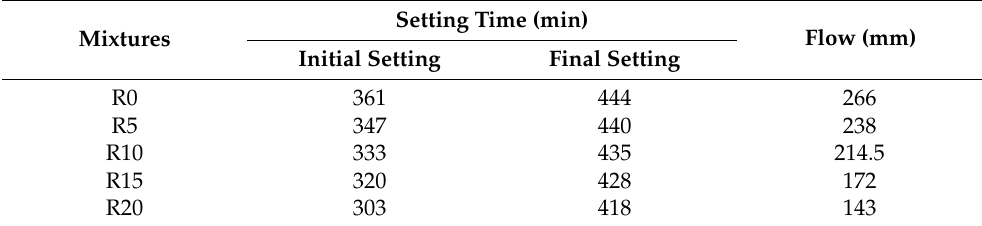
Table 3. Fresh properties of pastes and